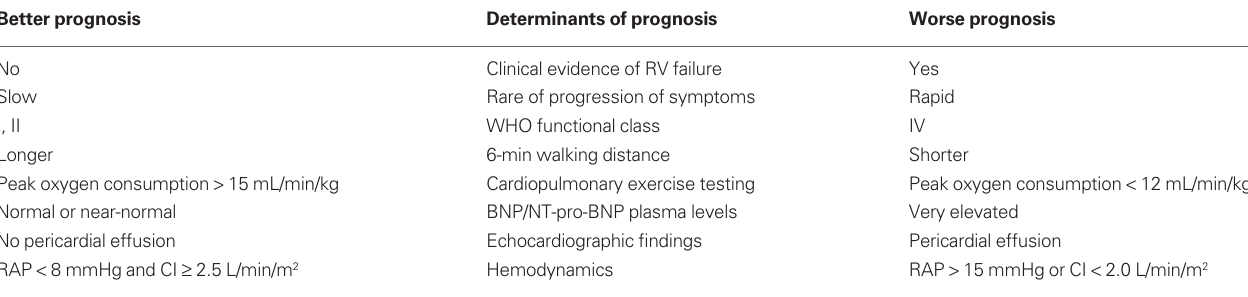
Table 3 | Parameters with established importance for assessing disease severity, stability, and prognosis. Better prognosis